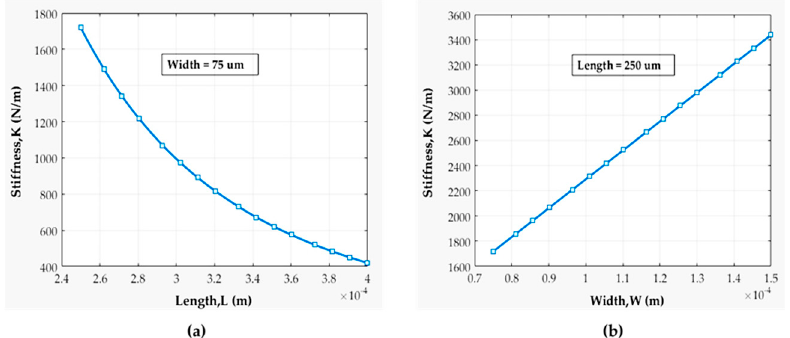
Figure 12. Stiffness variation with respect to ( a ) beam’s length and ( b ) beam’s width.